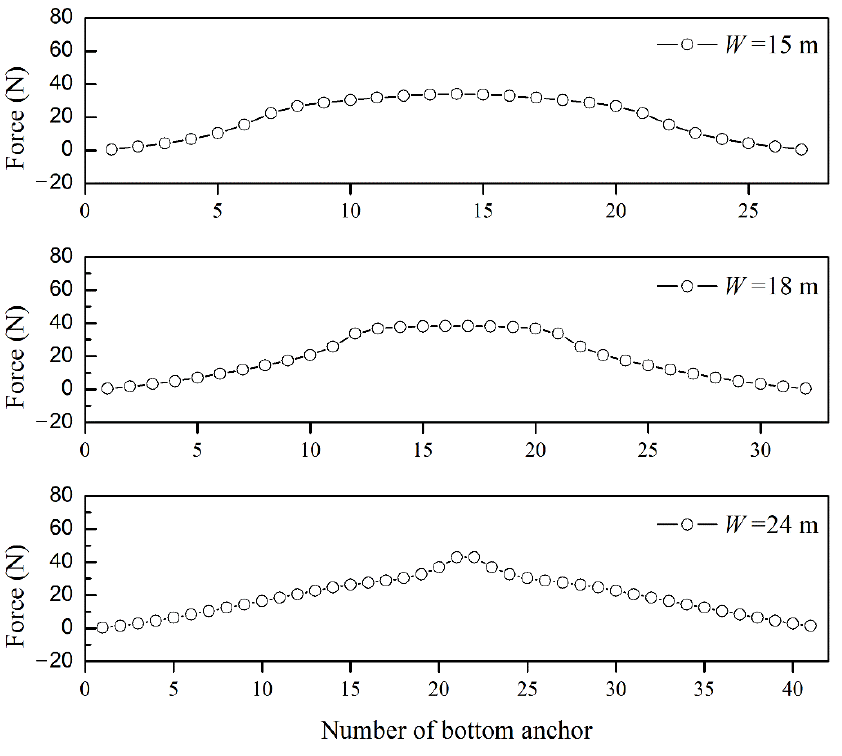
Figure 12. Maximum tension force on the bottom moorings for different trash-blocking net widths.